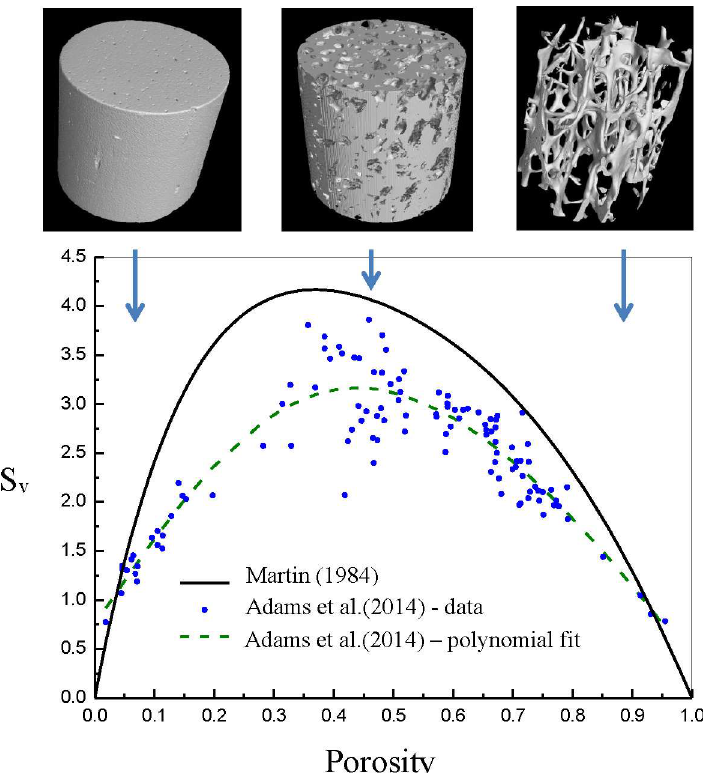
Fig 1. Specific Surface of bone as function of porosity (porosity = 1-BV/TV) from the analysis produced by Martin [30] (solid curve) and recent precise measurements by Adams et al.[28] (circles with a dashed line which is a fifth degree polynomial